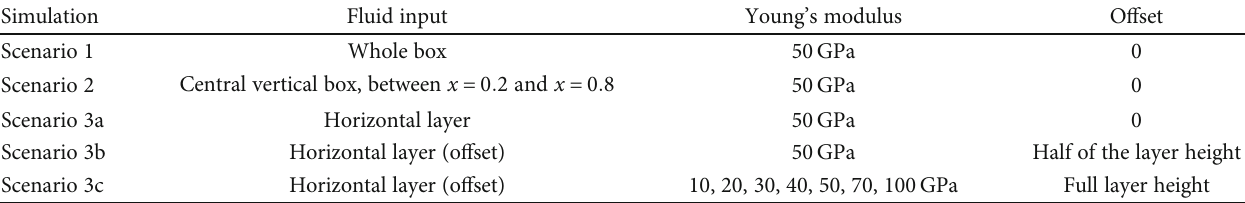
Table 1: Summary of numerical simulation sets providing parameters of individual